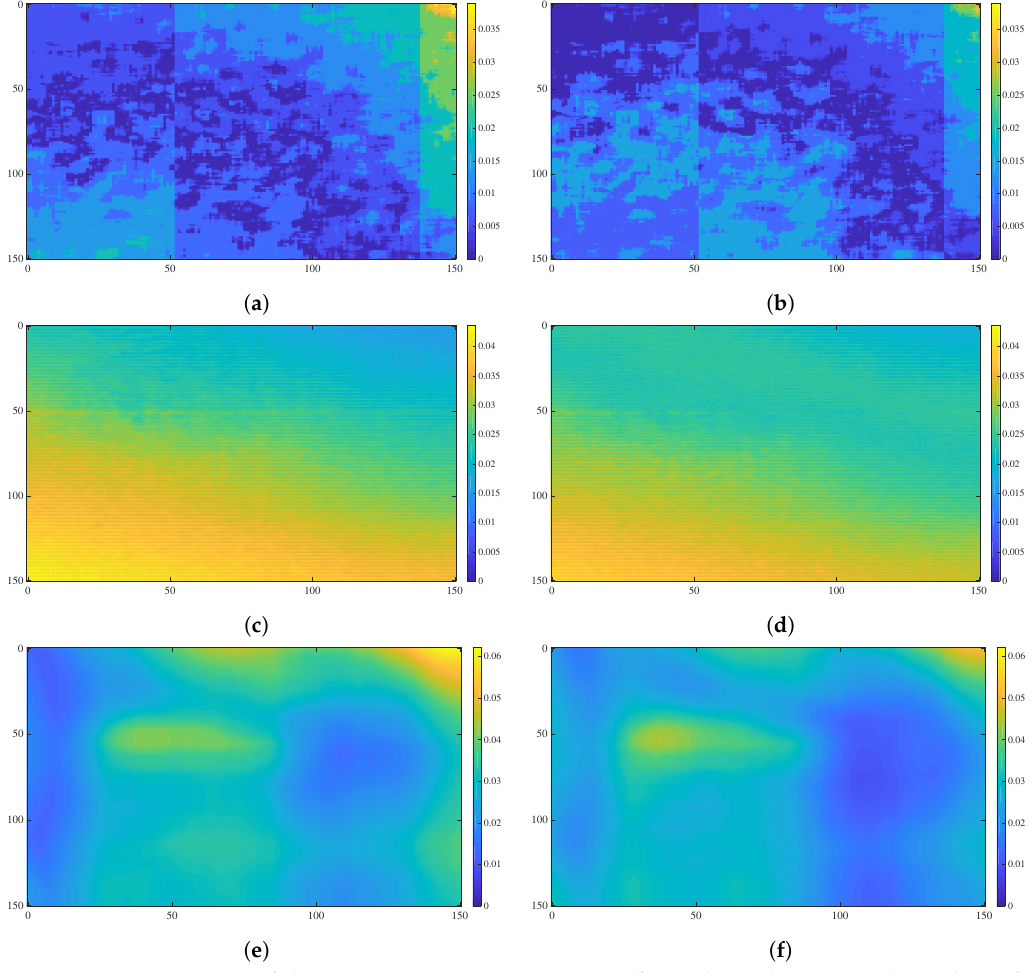
Figure 7. Comparison of the average RMS error in meters (for each pixel in a central window of 150 × 150) of 300 depth maps captured with Kinect v1 (640 × 480 px), Kinect v2 (512 × 424 px) and ZED camera (672 × 376 px), ( a , c , e ) before and ( b , d , f ) after a simple correction process. The more yellow the pixels are, the more RMS error